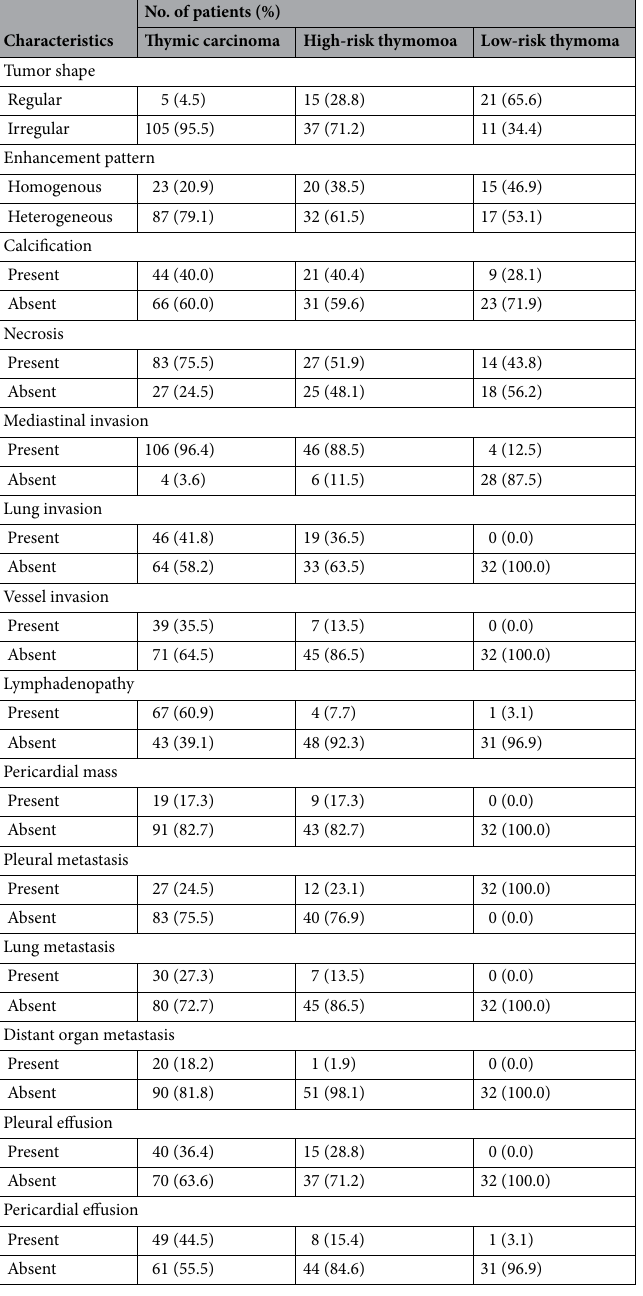
Table 2. CT features of 194 patients with thymic epithelial